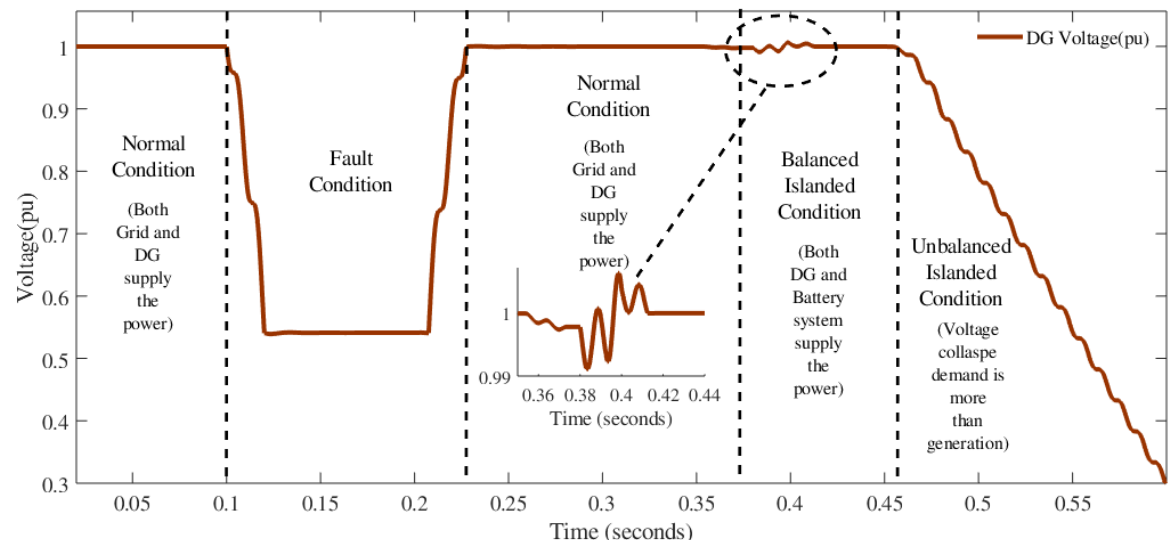
Figure 14. Voltage profile at the DG bus under different system conditions. The voltage under the normal condition is 1 p.u., and with the fault inception it dips down to 0.52 p.u. After 0.35 s, the system is in islanding mode with both the DG and battery system supplying the load. After 0.45 s, the load is increased and results in a voltage